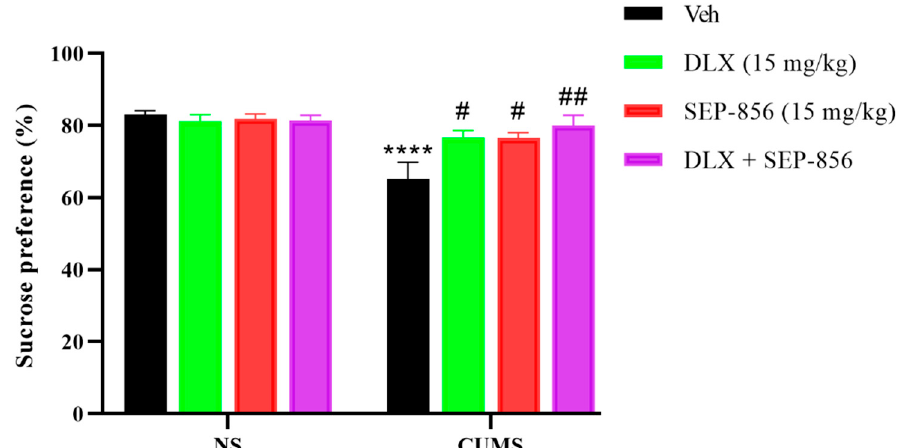
Figure 4. Effects of duloxetine (15 mg/kg), SEP-856 (15 mg/kg), and their co-administration on the sucrose preference in the CUMS model of depression in ICR mice. Values are expressed as the means ± SEM from 5–7 mice and were analyzed by two-way ANOVA followed by Bonferroni’s multiple comparisons test. **** p < 0.0001 vs. NS-Veh; # p < 0.05, ## p < 0.01 vs. CUMS-Veh. NS, non-stressed; CUMS, chronic unpredictable mild stress. DLX, duloxetine.